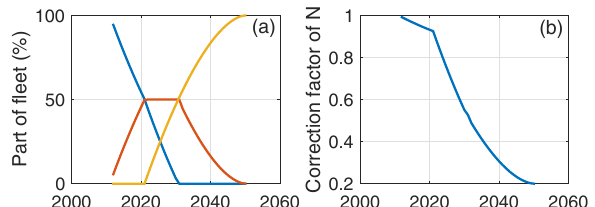
Figure 10. (a) Estimated part of fleet complying with TIER I (blue), TIER II (red), and TIER III/NECA (orange) restrictions. (b) Correc- tion factor for OXN deposition from shipping, using the implemen- tation of TIER II and TIER III in a NECA from